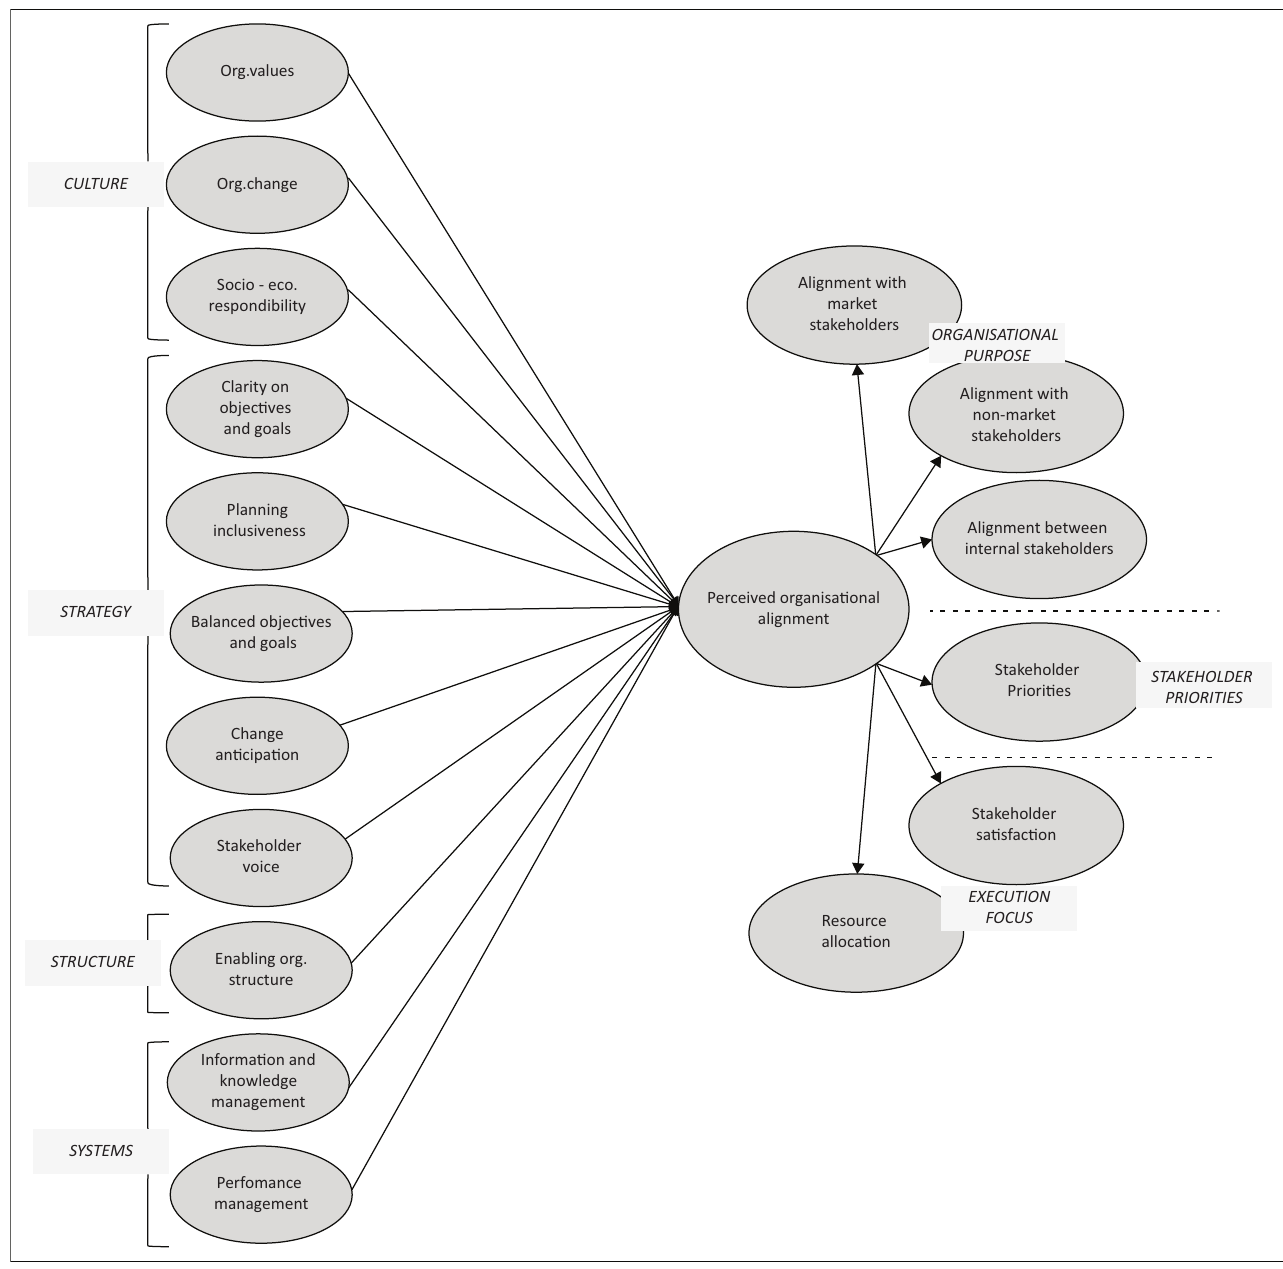
FIG URE 2: Framework of organisational